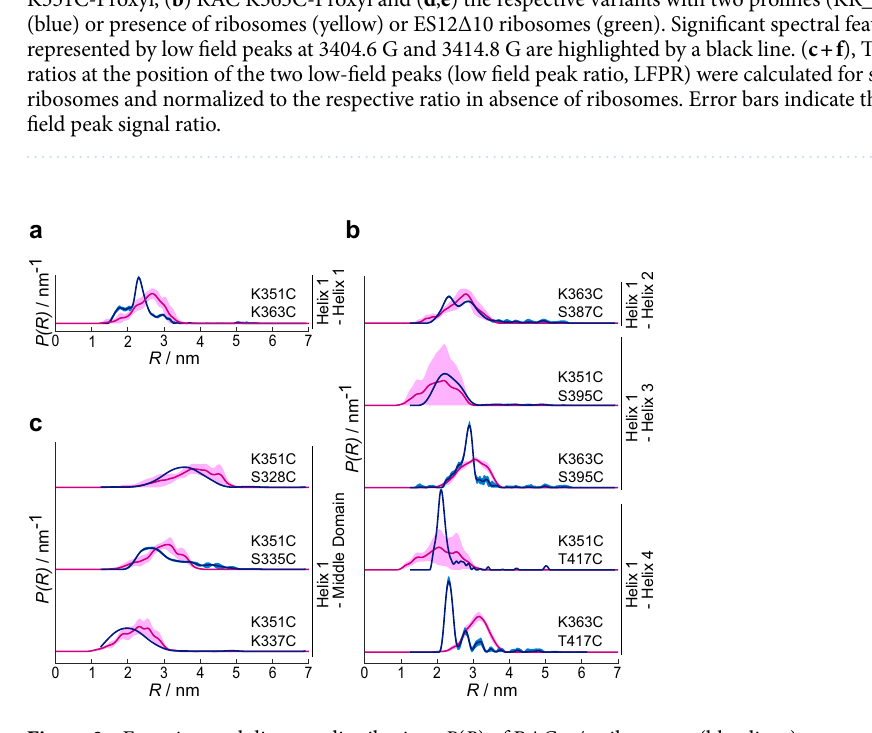
Figure 3. Experimental distance distributions P ( R ) of RAC w/o ribosomes (blue lines) compared to simulated distance restraints based on our working model (magenta lines). The data were obtained by background correction with the use of DEERNet 12 and Tikhoniv regularization. Shaded areas represent the uncertainty range according to the validation (light blue, see “Methods”) or standard deviation of clustered structures from two independent simulations (light magenta). RAC was labeled at ( a ) two sites within helix 1 of Zuo1’s 4HB, ( b ) one site in helix 1 and a second site in helix 2–4, or ( c ) one site in helix 1 and a second site in the middle